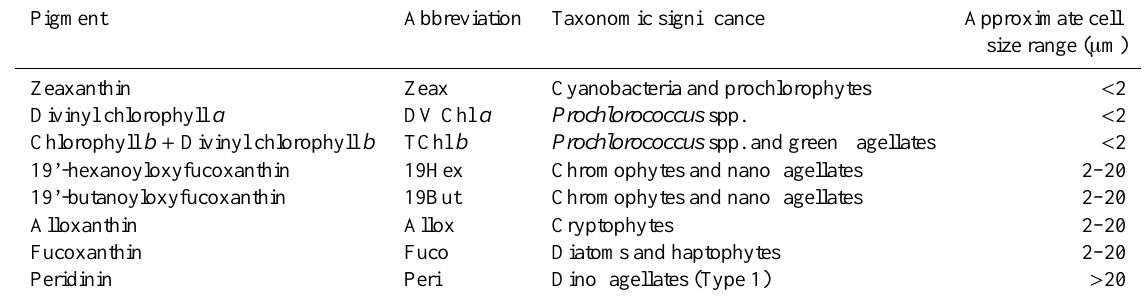
Table 2. Summary of key diagnostic phytoplankton HPLC pigments (adapted from Vidussi et al., 2001): pigment name, common abbrevia- tion, associated taxonomic group and typical size class. For more detailed taxonomic associations and definitions, see Higgins et al.